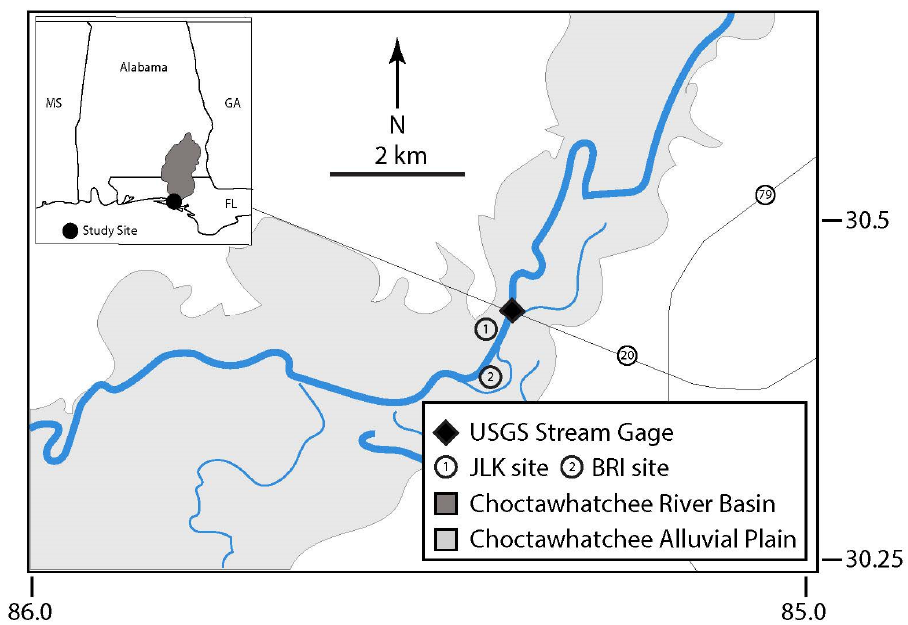
Figure 1. The Choctawhatchee River basin is shown in the inset panel ( dark grey ). The river channel ( blue line ) and alluvial plain ( light grey ) are shown in the primary panel along with the tree ring collection site at John’s Lake and Bruner’s Island ( numbered circles ); and the United States Geological Survey (USGS) gage near Bruce, Florida ( black diamond ).